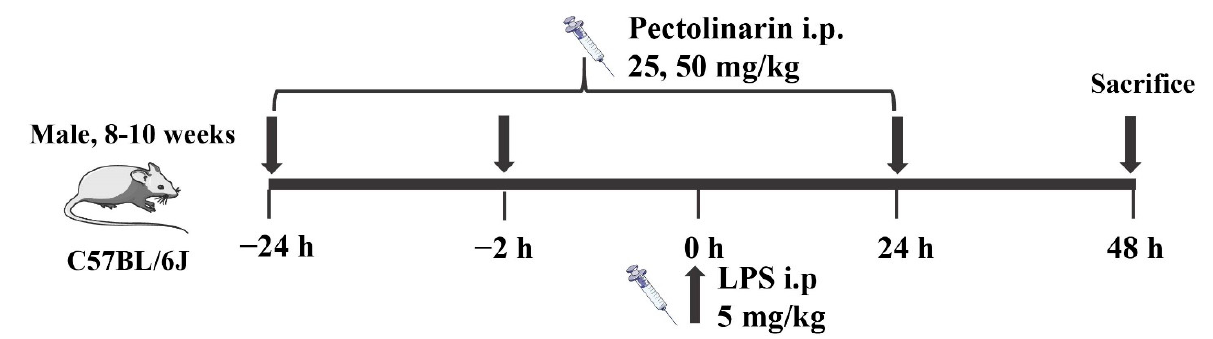
Figure 11. Timeline of the animal